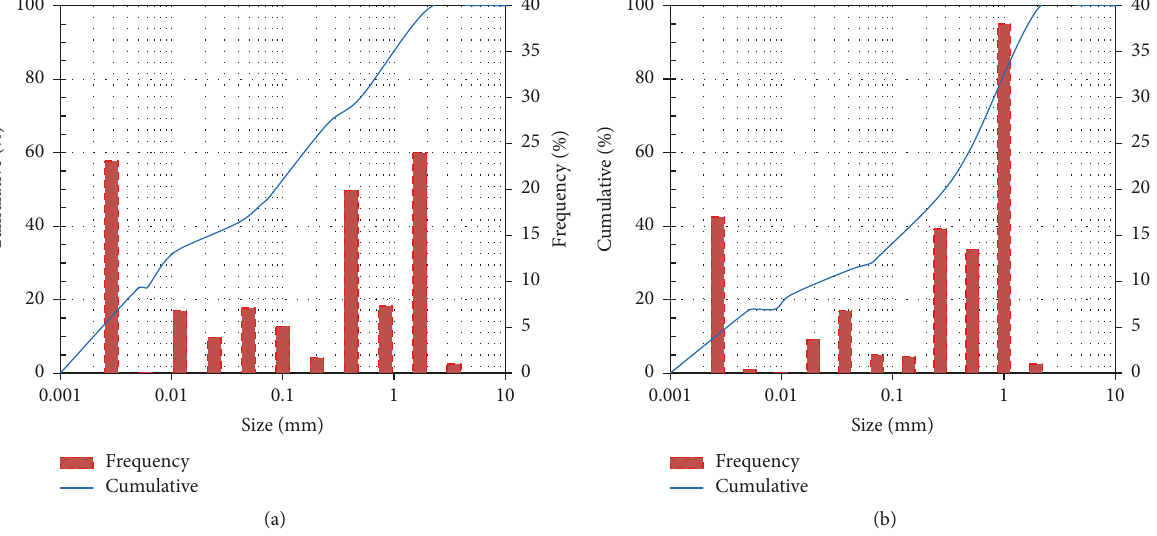
Figure 12: Particle size distribution (PSD) of infilling materials: (a) Sample 1; (b) Sample